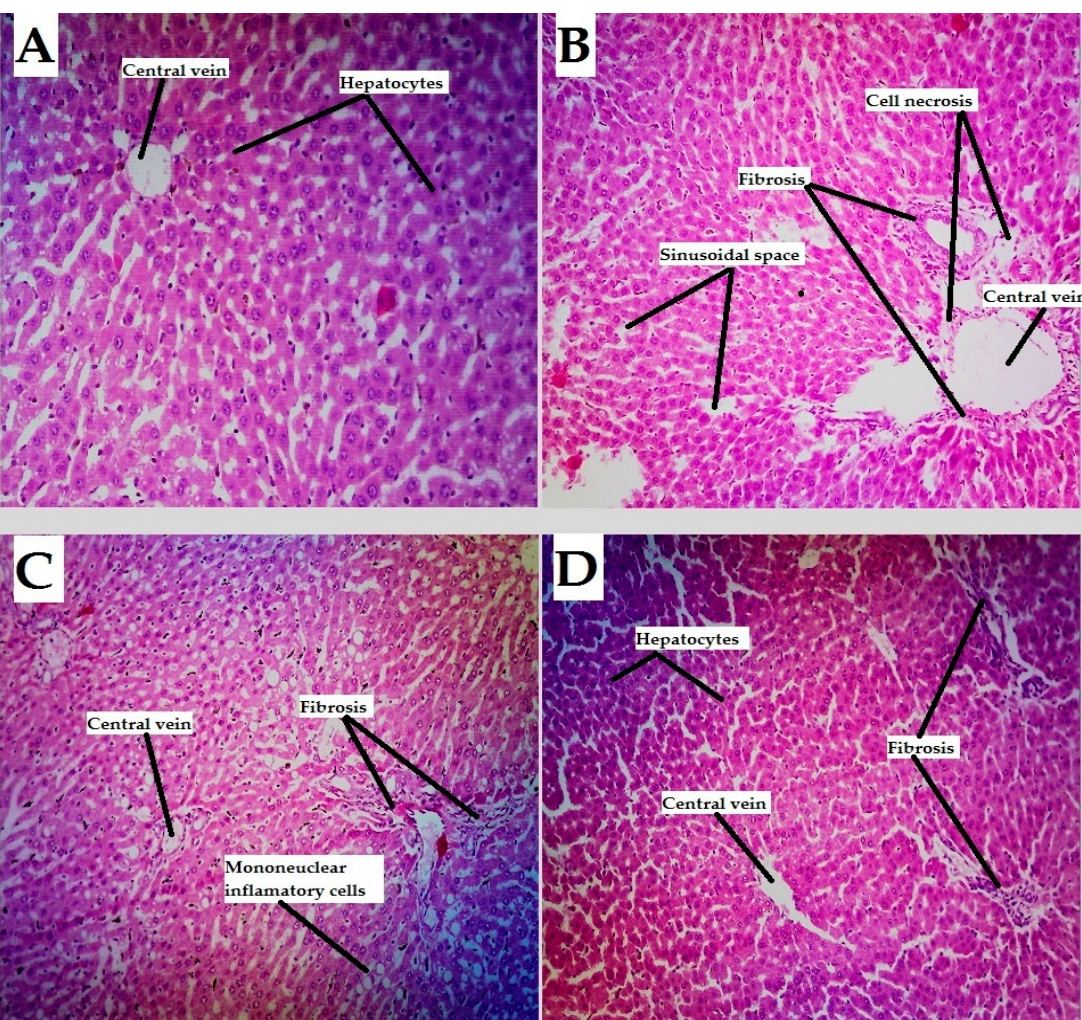
Table 5. Histopathological scoring of liver tissues in control and treated groups of rats. Comp-1 Toxic Control Normal Control 5 mg/kg 5-FU-Treated Groups (Normal Saline) Treated Group Treated Group Group Sinusoidal 0 2 1 spaces Group Necrosis 0